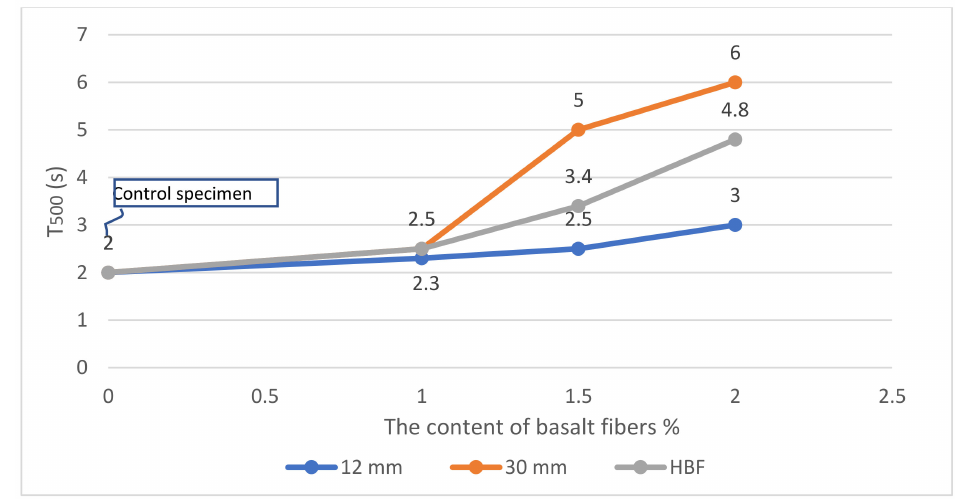
Figure 8. Variation of the T500 flow time with BFs fibre content for different fibre